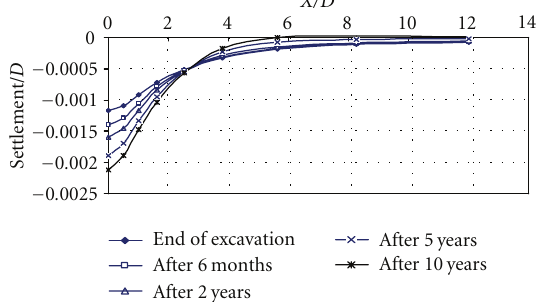
Figure 24: Variation of the subsurface settlement along section C-C using di ff erent k 0